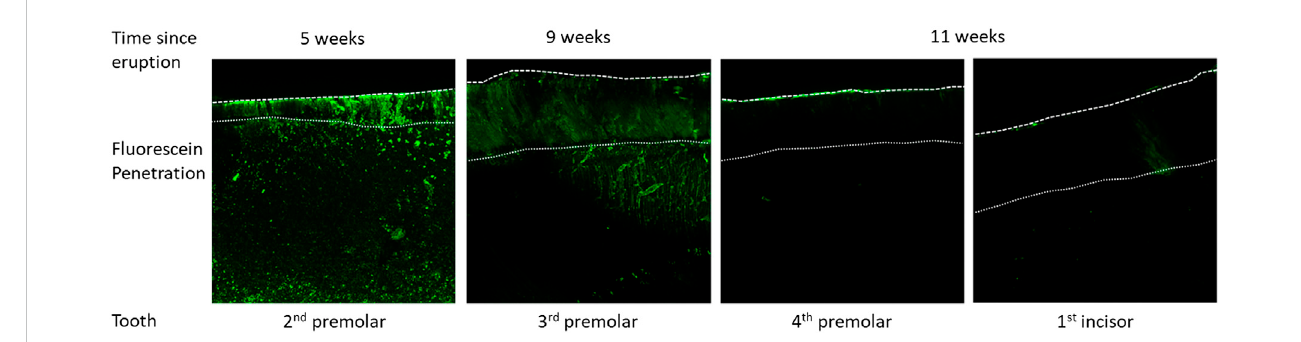
FIGURE 6 Fluorescein penetration after application on the surface of the tooth crown, followed by cleaving thetooth to expose the fracture surface that is imaged by confocal laser scanning microscopy to detect fl uorescein distribution within enamel as a function of time post-eruption.